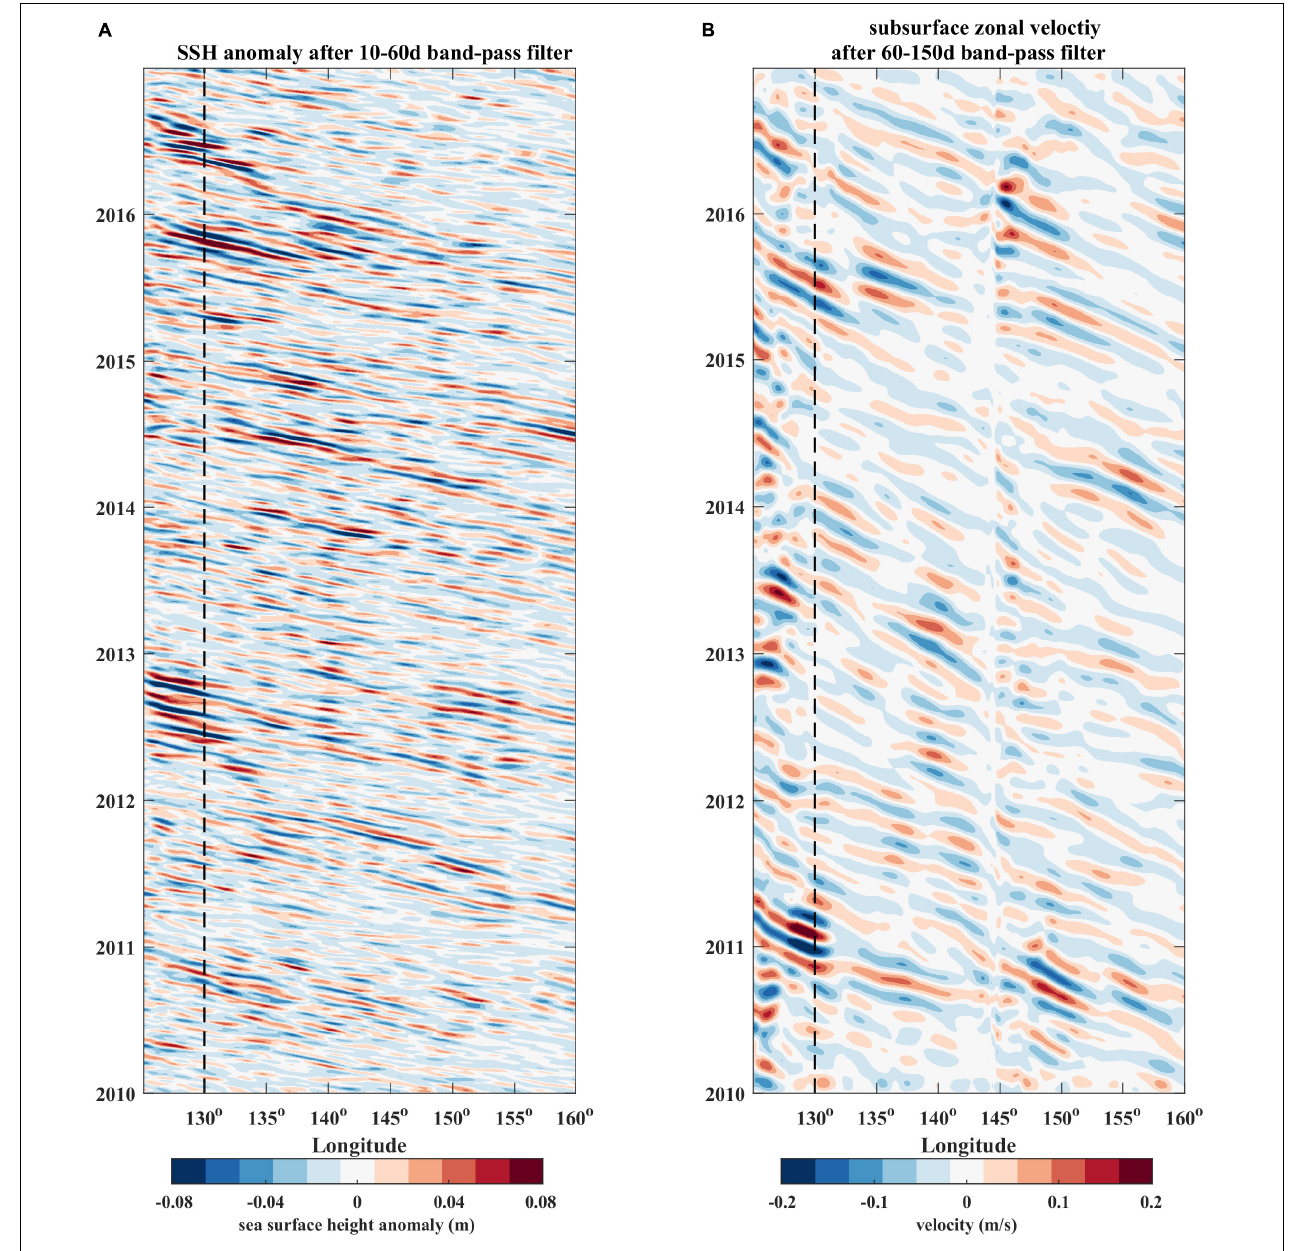
FIGURE 6 | (A) Time-Longitude plot of the 10–60 days band-pass filtered SSH anomalies between western boundary and 160 ◦ E along 13 ◦ N in the WTP. (B) Time-Longitude plot of the 60–150 days band-pass filtered subsurface zonal velocity (400–600m) along 13 ◦ N between western boundary and 160ˇrE in the WTP from OFES outputs. The dashed lines denote the location of 130 ◦